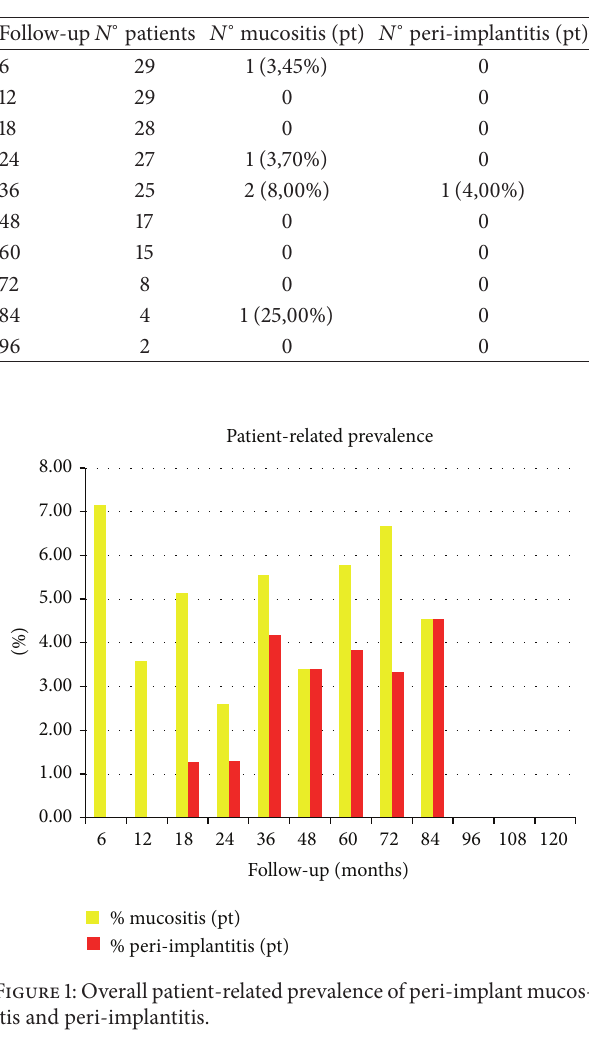
Table 1: Patient-related prevalence in the mandible. Table 2: Patient-related prevalence in the maxilla.